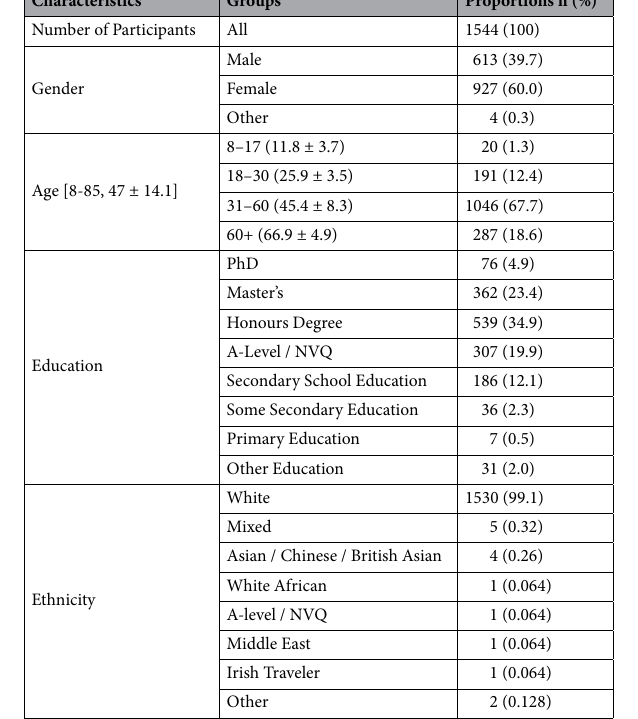
Table 1. Characteristics of study participants. The values for age are presented in the range (mean ± standard deviation (SD)).